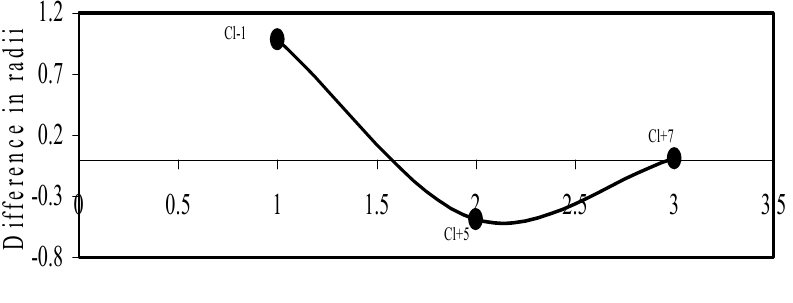
Figure 13. Plot of difference in experimental and theoretical radii of Cl in different oxidation